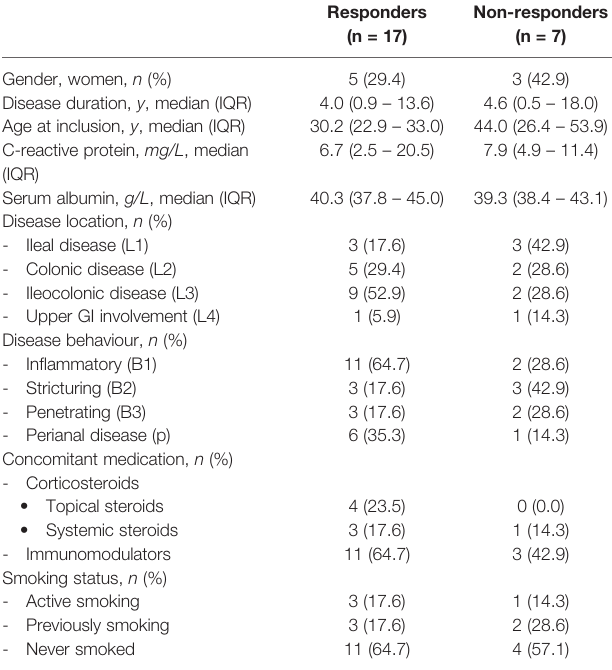
TABLE 1 | Baseline characteristics of the Crohn ’ s disease